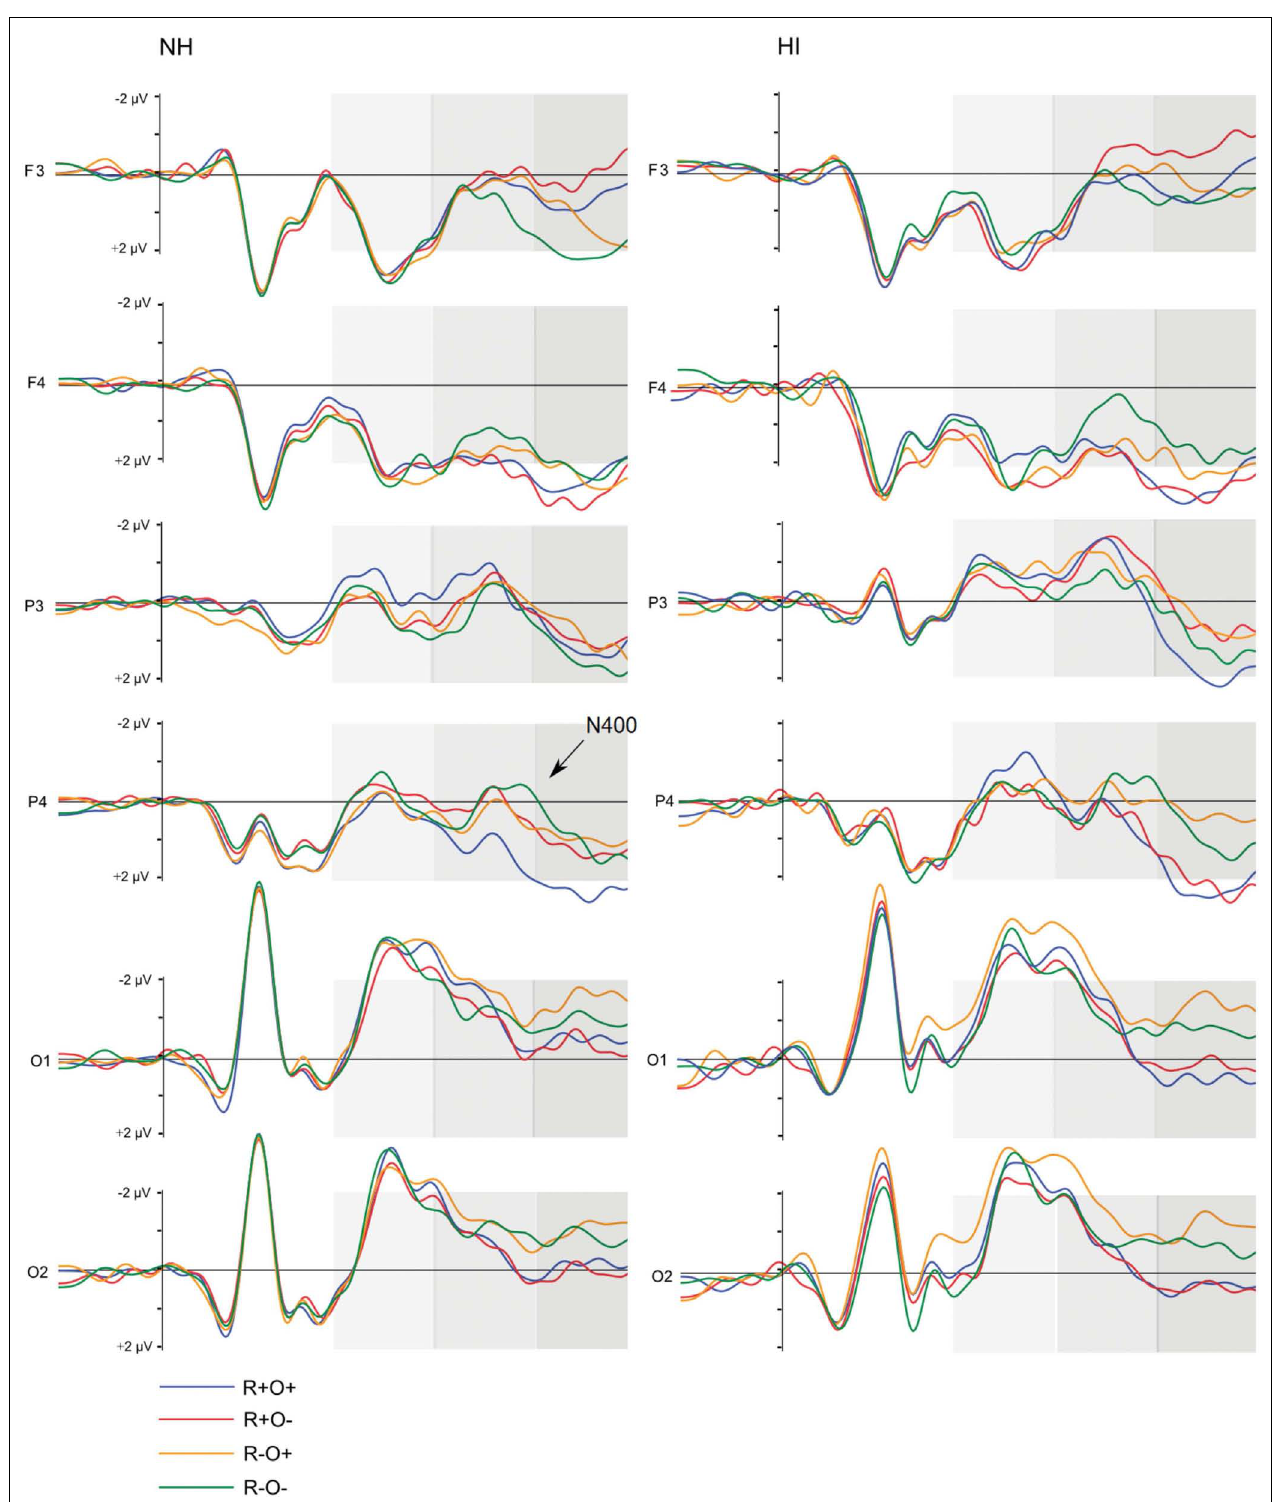
FIGURE 7 | Grand average ERP waveforms elicited by R + O + , R + O − , R − O + , and R − O − target words in each group, short ISI condition. The shaded areas mark the 100–300, 300–500, and 500–700ms time-windows, respectively.